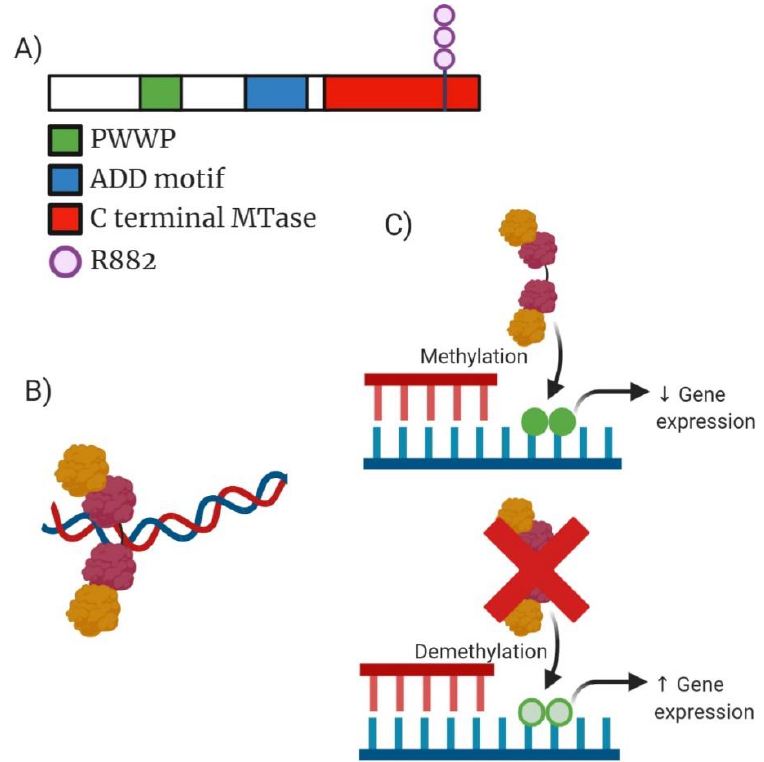
Figure 2. Analysis of DNMT3A molecular structure, active tetramer structure, mechanism of action and drug target action. ( A ) Domain structure of mammalian DNMT3A enzyme consisting of 912 amino acid residues. Green highlighting PWWP domain which is required for directing DNA methylation. Blue highlighting ADD (ATRX-DNMT3A-DNMT3L) motif responsible for mediating protein–protein interaction to transcription factors. Red highlights the C-terminal MTase domain contains highly conserved regions of C5-DNA methyltransferases. Additionally, highlighted is the structural position of the most common mutation occurring within DNMT3A (R882). ( B ) Active tetramer formed from two DNMT3A and two DNMT3L molecules resulting in an increased affinity for DNA causing more efficient methylation. ( C ) Mechanism of action for both wild-type (WT) DNMT3A and the truncated mutant DNMT3A . WT DNMT3A causing methylation which can reduce expression of gene expression compared to mutant DNMT3A which can often result in increased expression of genes depending on the context of the cellular function occurring.